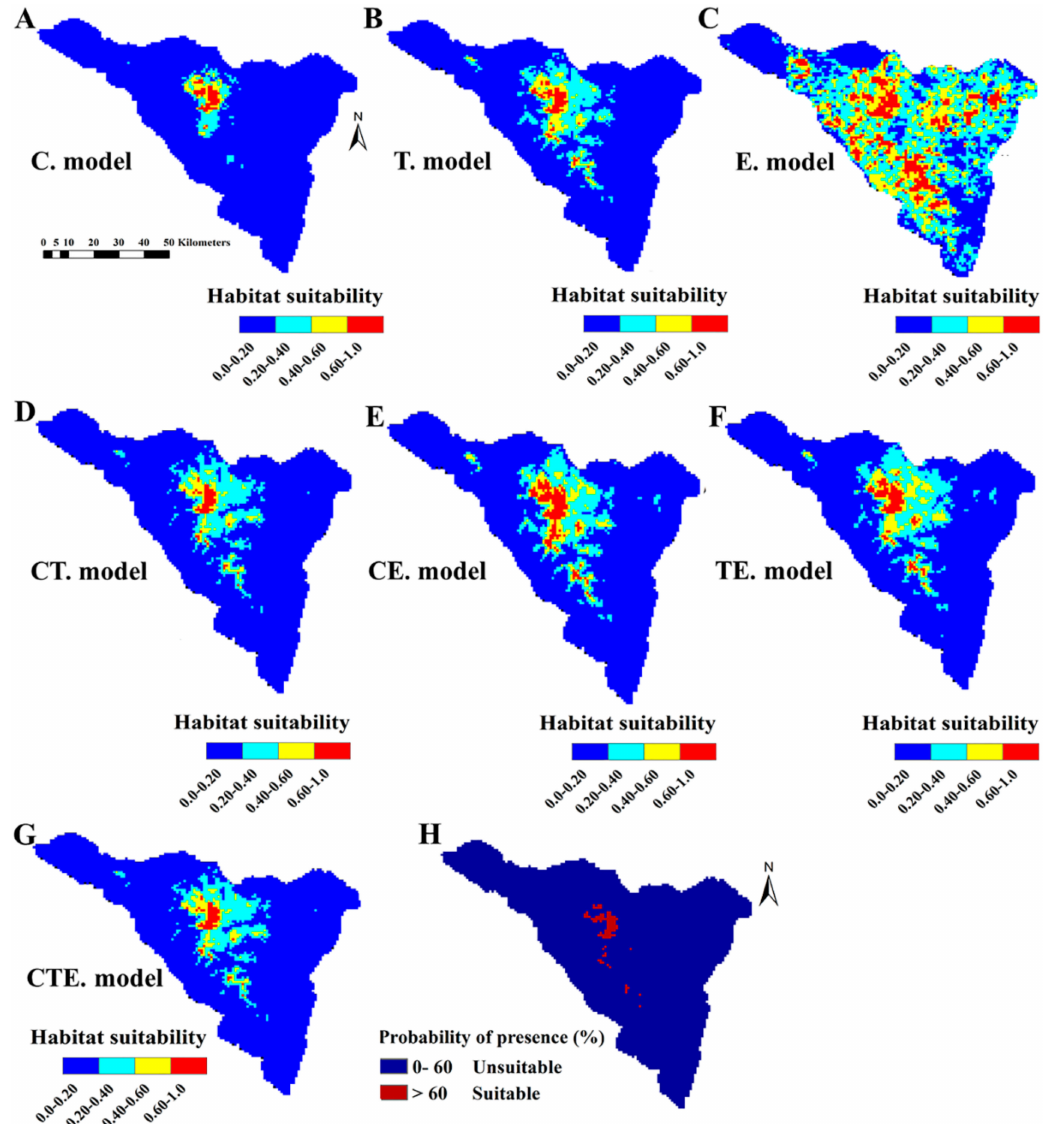
Figure 3. Predictive map for the current habitat suitability ( A – G ) of P. boveana using seven sets of predictor variables (climate only: C. model, topography only: T. model, edaphic only: E. model, climate-topography: CT. model, climate-edaphic: CE. model, topography-edaphic: TE. model, climate-topography-edaphic: CTE. model) in the St. Catherine area; habitat suitability classes include unsuitable (0–0.20), low suitability (0.20–0.40), moderate suitability (0.40–0.60), and high